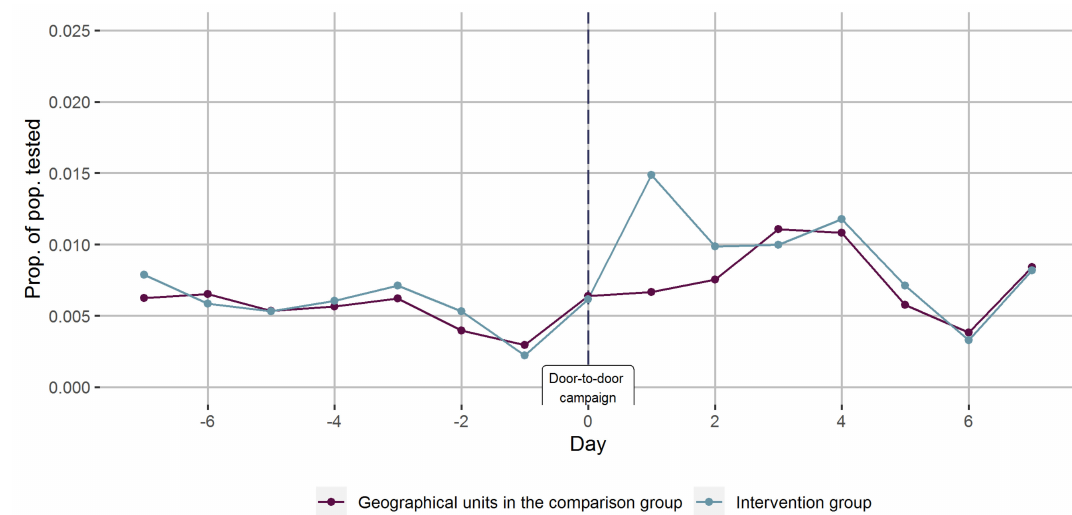
Figure 4. Joint proportions of the population tested for COVID-19 before and after totally three door-to-door campaigns promoting COVID-19 testing (day 0) accompanied by mobile testing facilities in geographical units stratified on intervention.